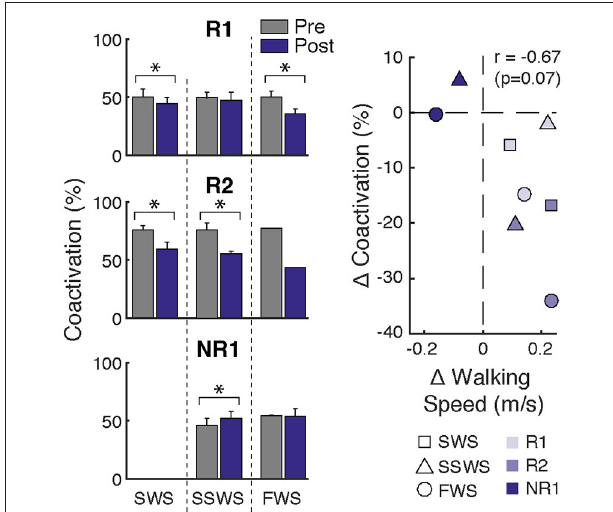
FIGURE 4 | Changes in ankle muscle coactivation after FastFES. (Left) Ankle muscle coactivation between SOL and TA during the gait cycle while walking at slow-walking speeds (SWS), self-selected walking speeds (SSWS), and fast walking speeds (FWS) pre- and post-training. Coactivation was calculated as the percentage of overlapping muscle activity as in Winter 1990. Participants R1 and R2 demonstrated decreases in coactivation after FastFES, whereas Participant NR1 increased coactivation. (Right) Average change in coactivation vs. average change in walking speed at each speed condition. Correlation analysis revealed a trend for increased walking speeds post-training to be associated with reduced SOL/TA muscle coactivation ( r = − 0.67, p = 0.07). * p <